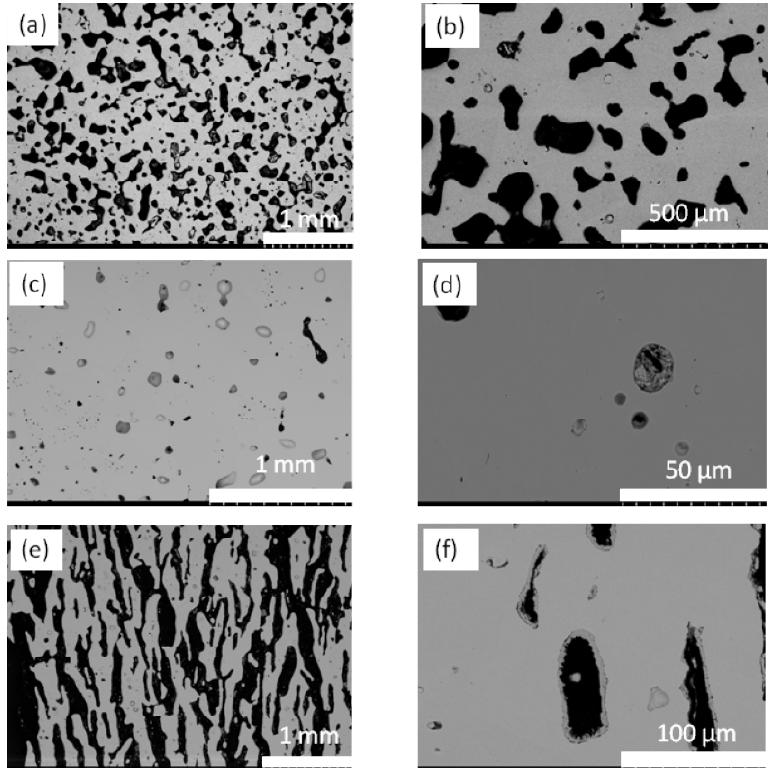
Fig. 4. SEM data of the polished surface of the reference sample – pure copper, Specimen 1: (a) magnitude×1 and (b) magnitude×10; composite with 0.1 wt.% of carbon addition, Specimen 2: (c) magnitude×1 and (d) magnitude×100; composite with 3.0 wt.% of carbon addition, Specimen 5: (e) magnitude×1 and (f)